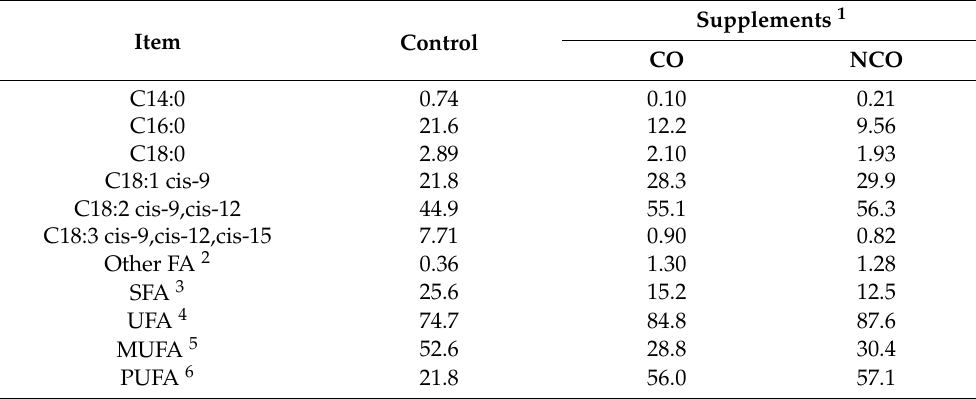
Table 2. Fatty acid composition (g/100 g of FA) of the control diet and supplements.